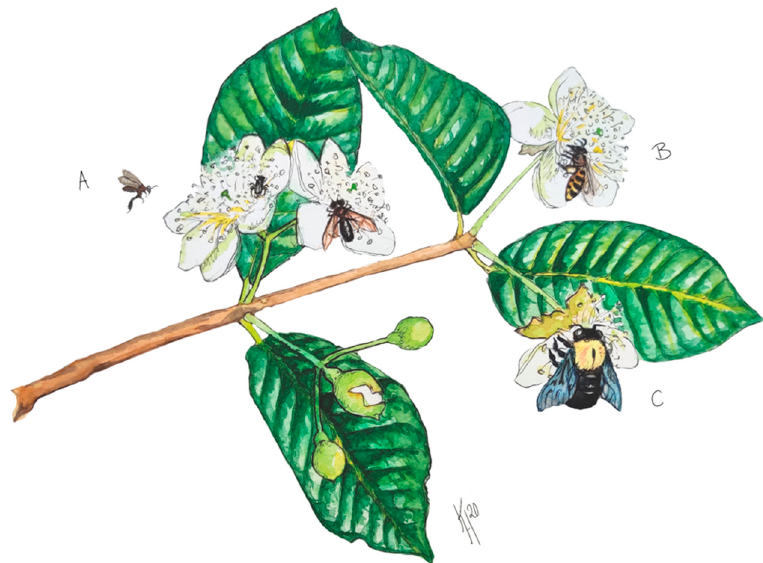
Figure 1. Illustration of guava flowers at different stages (bud, cracked bud and open flower) and the most important pollinators: (A) Three species of stingless bee, from left; Heterogona itama, Tetragonula laeviceps and Geniotrigona thoracica. (B) Asian honey bee Apis cerana. (C) Carpenter bee Xylocopa (Koptortosoma) aestuans